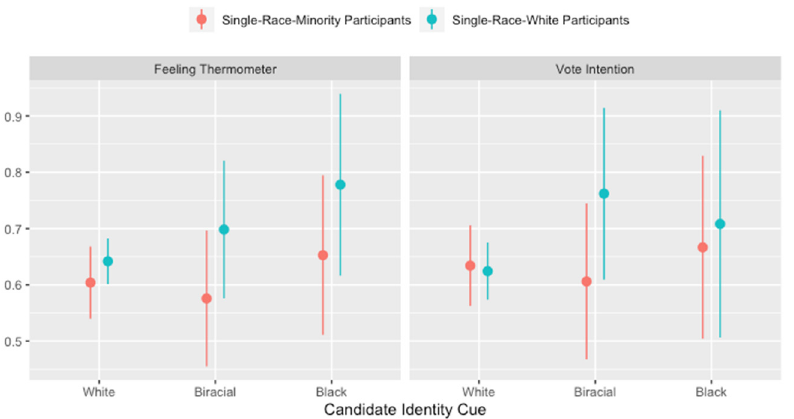
Figure A3. Mean feeling thermometer and vote intention ratings of hypothetical candidates from